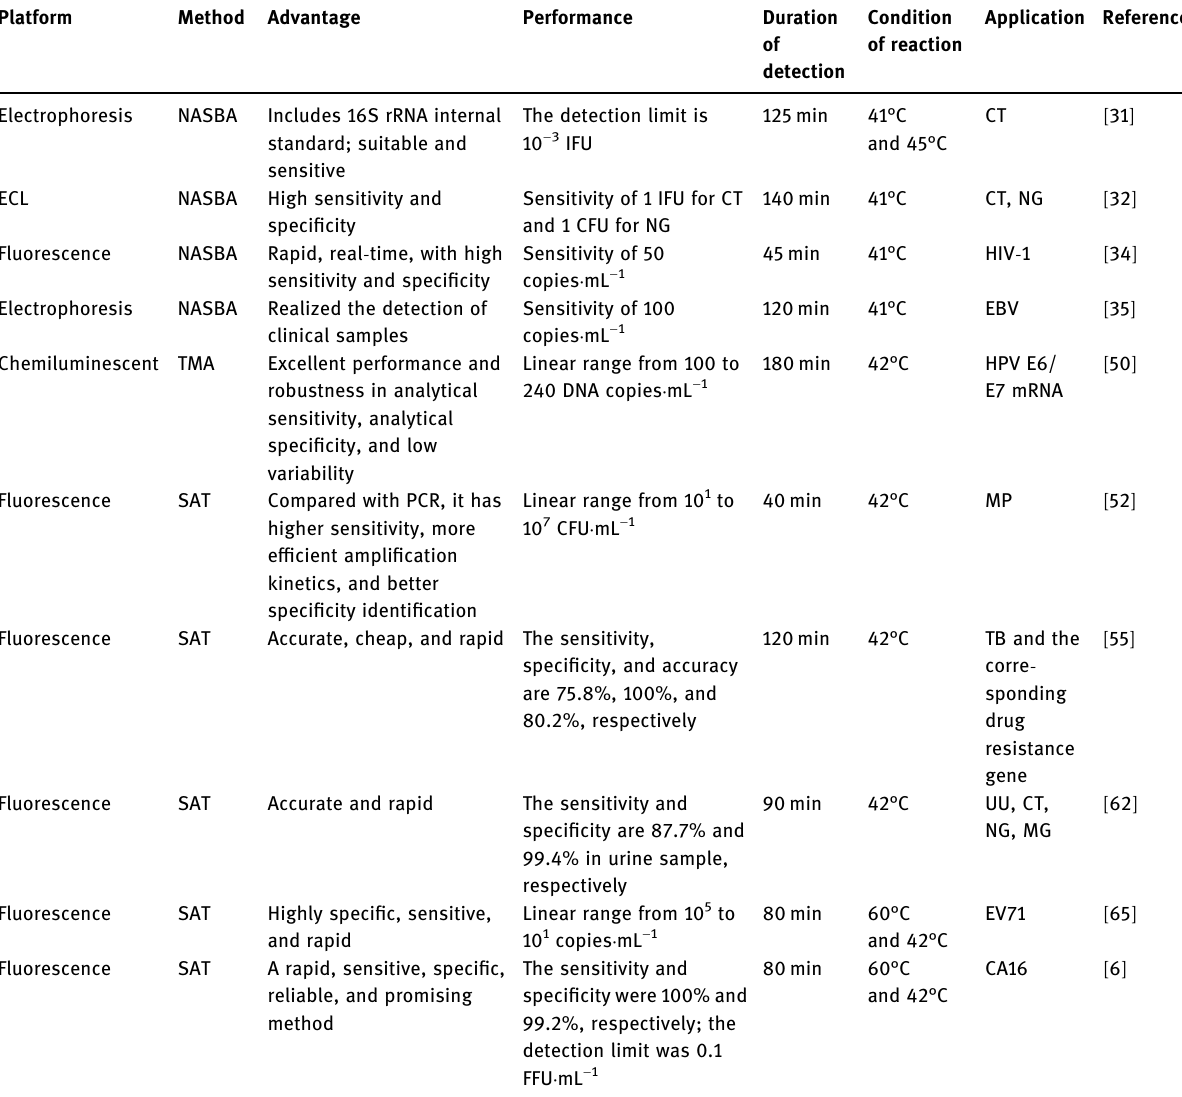
Table A1: Clinical application of transcriptional ampli fi cation strategy in RNA detection